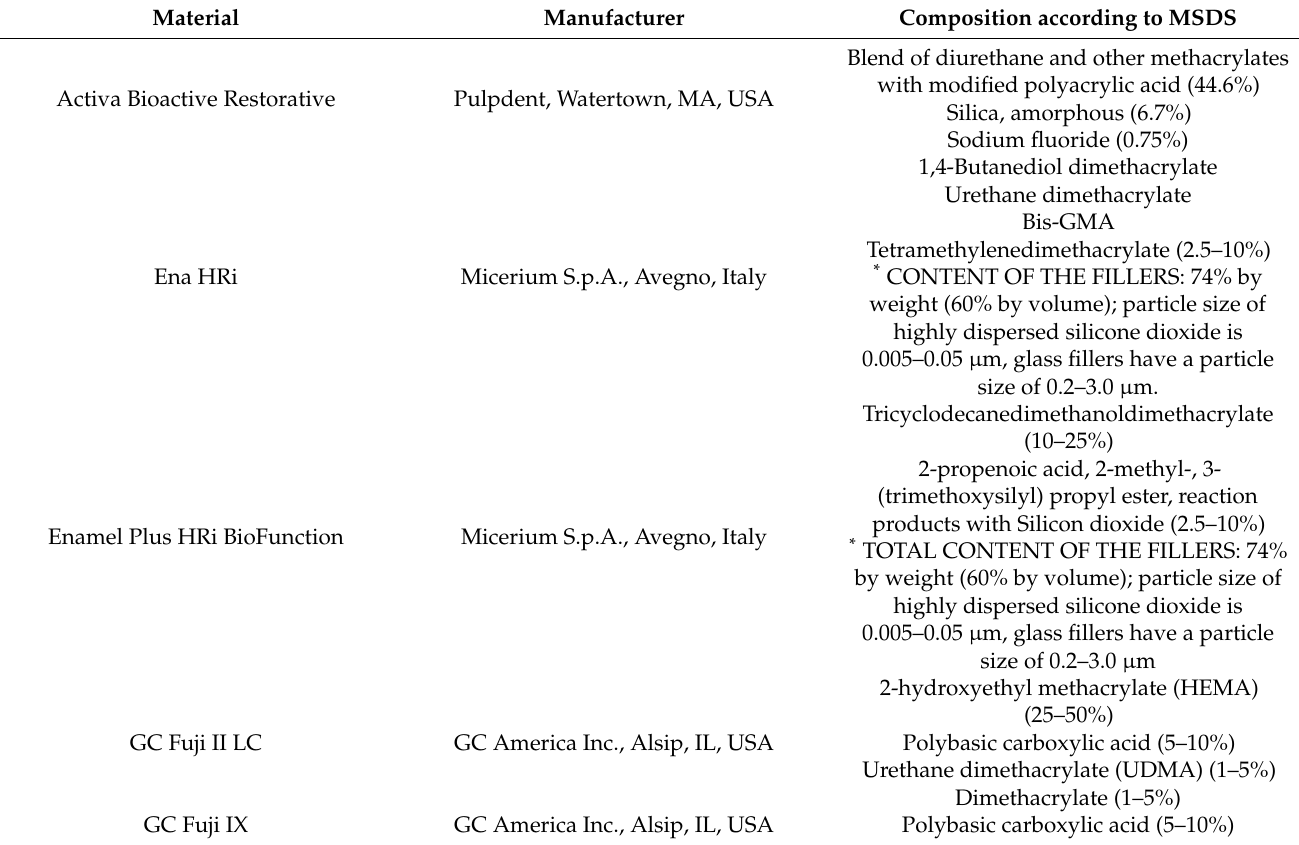
Table 8. Material composition according to Material Safety Data